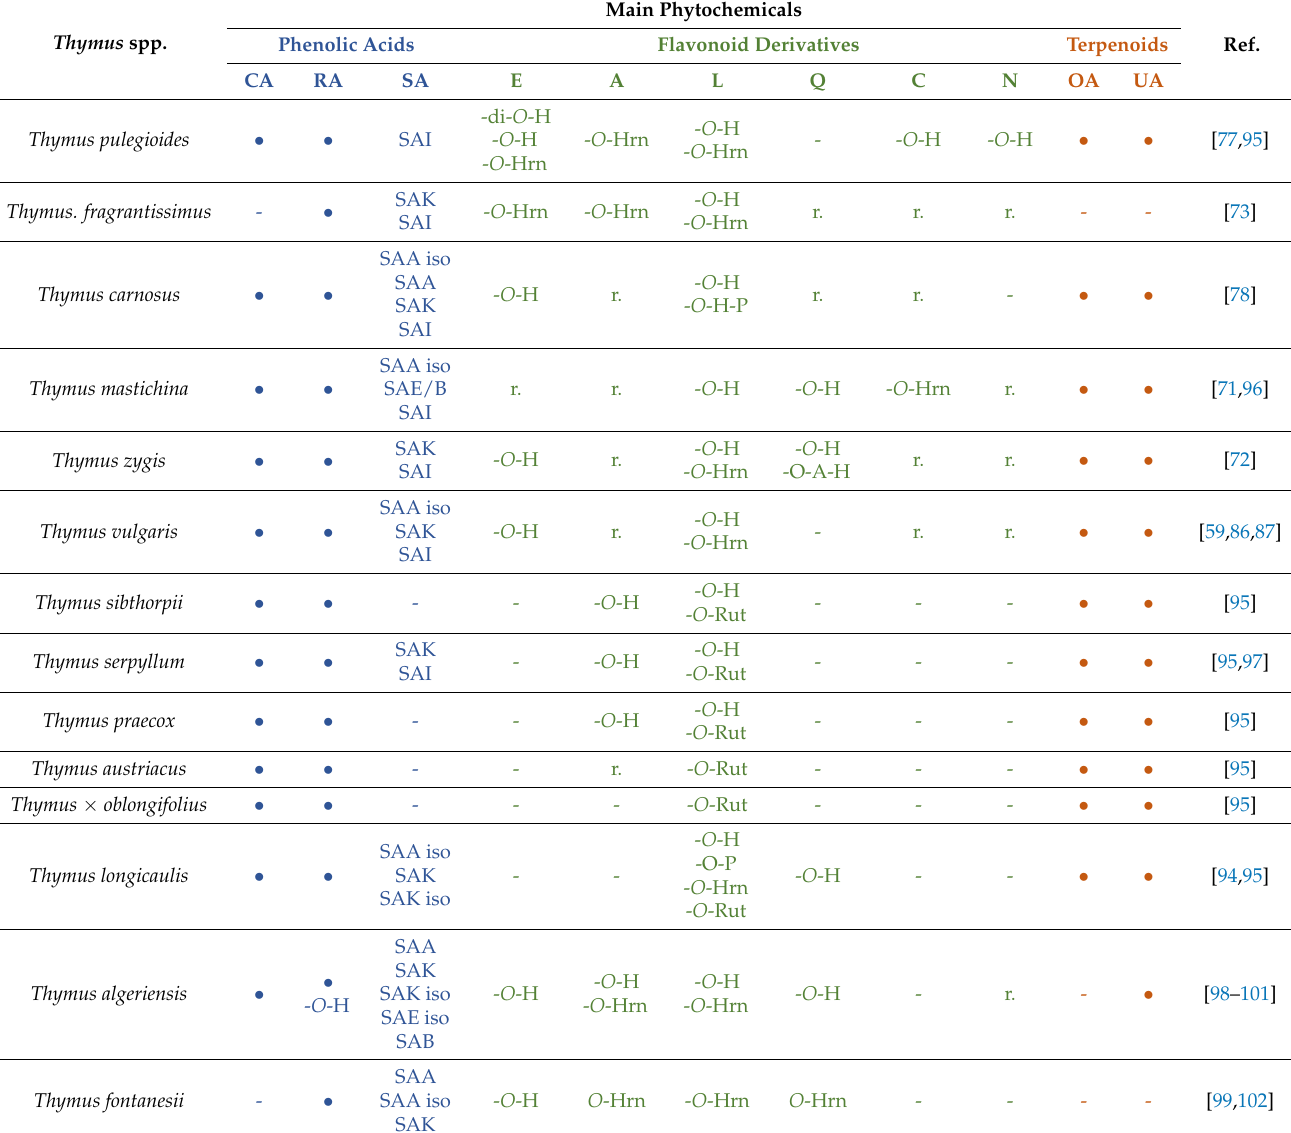
Table 1. Summary of common phytochemicals identified in some Thymus spp. extracts